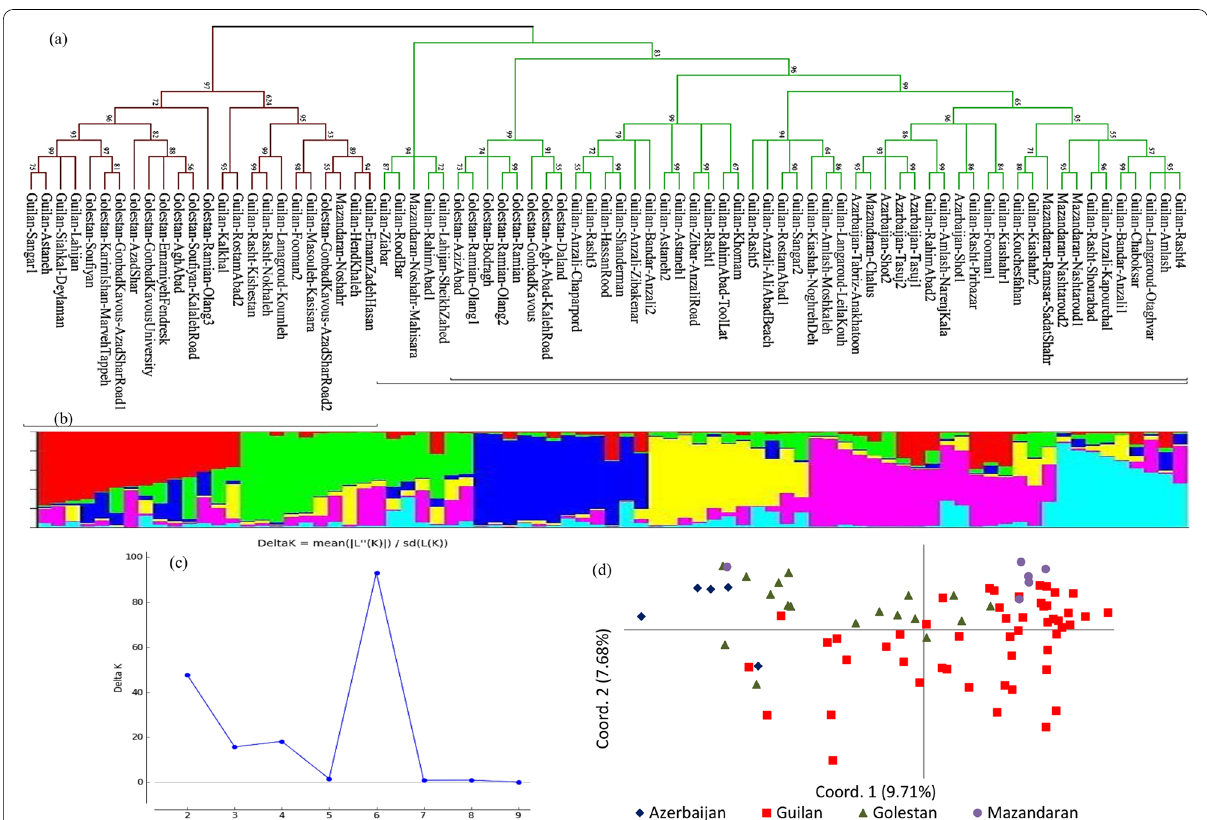
Fig. 4 The genetic relationships and population structure of the 79 Ae. tauschii accessions based on IRAP and model-based cluster analyses and PCoA. a Neighbor-joining phylogenetic tree, b population structure on K versus Δ K for determining ideal K -value, and d PCoA plot based on the first two